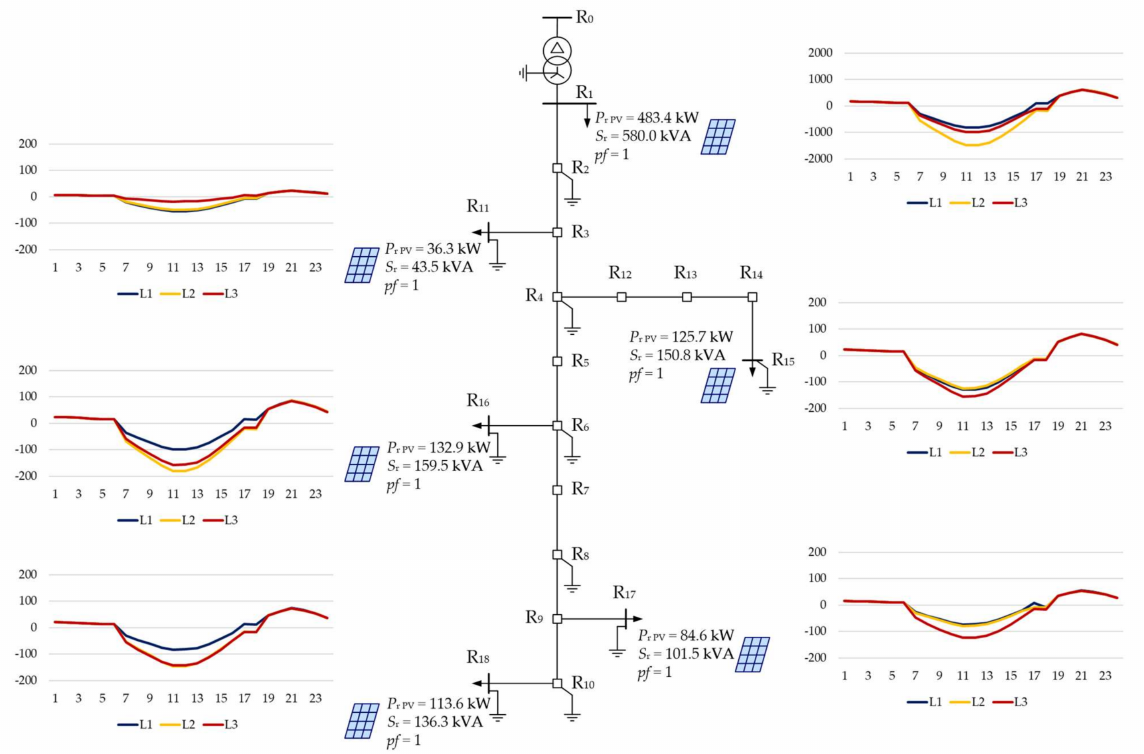
Figure A4. Daily simulation results for variant V5: phase currents